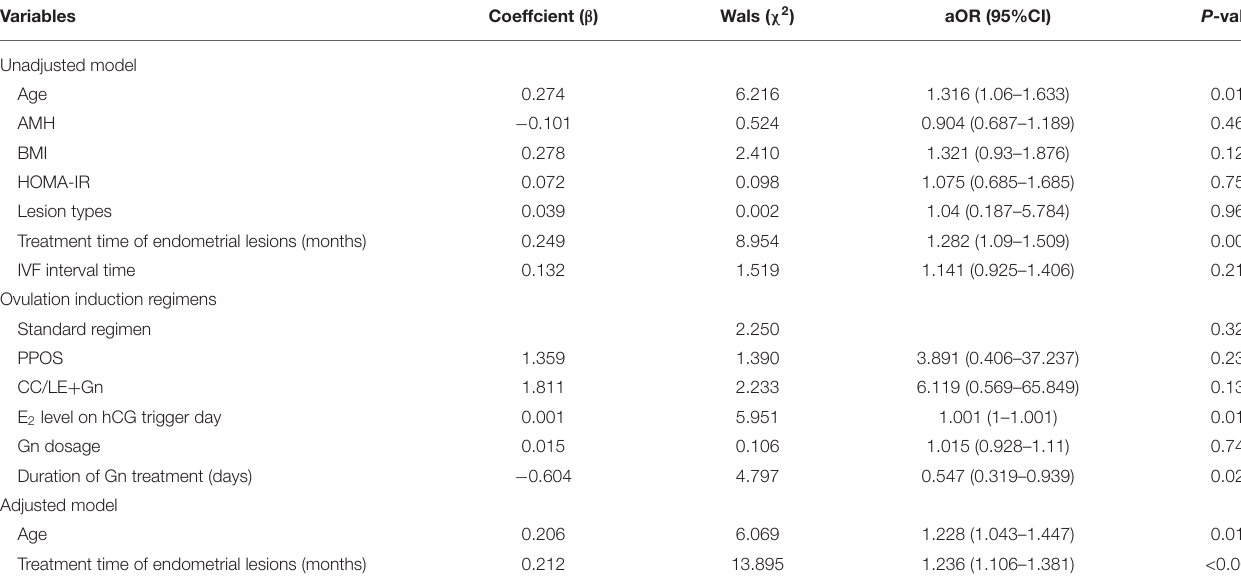
TABLE 4 | Multivariate logistic regression analysis of risk factors associated with the recurrence of endometrial diseases.